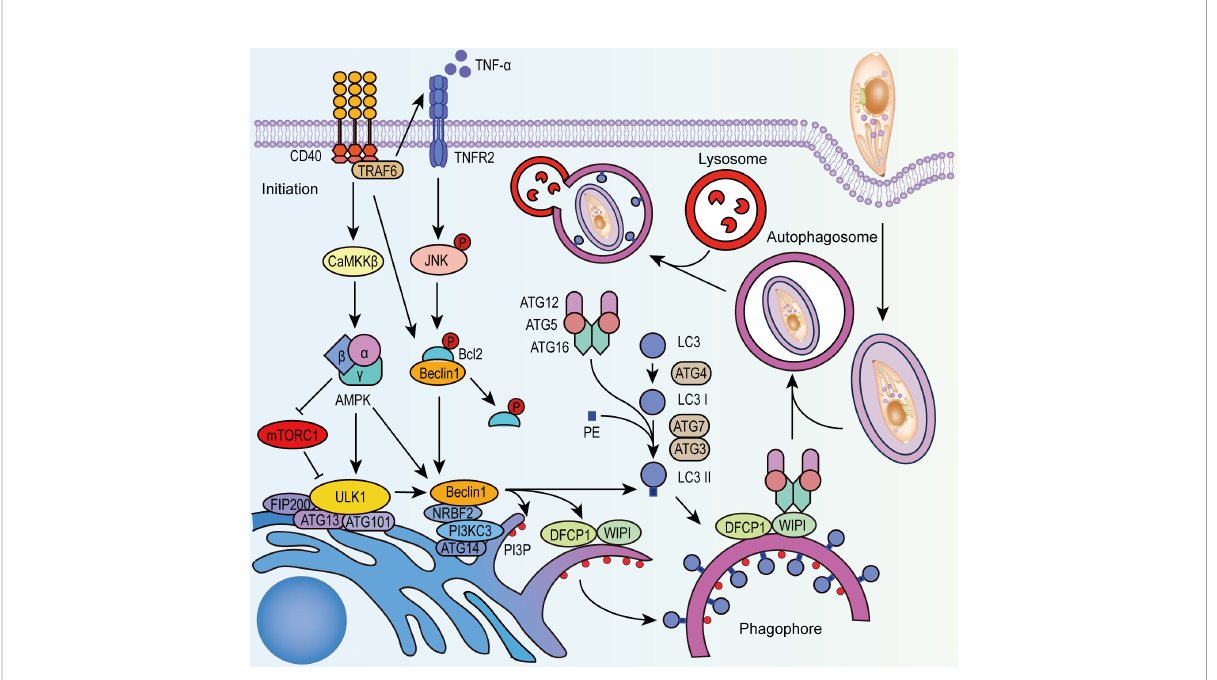
FIGURE 1 CD40 stimulates autophagy in T. gondii infection. After the invasion of T. gondii, CD40 activates ULK1 through CaMKK b -AMPK signaling and releases Beclin1 from phosphorylated Bcl-2. AMPK also alleviates the negative regulation of mTORC1 to ULK1. CD40 promotes the activation of TNFR-JNK signaling through phosphorylation. Activated ULK1 complex and Beclin 1-PI3KC3 complex recruit PI3P, DFCP1, and WIPI to form phagophore. With the recruitment of LC3-II that is lipidated from LC3 by ATG4, ATG7, ATG3, and ATG12-ATG5-ATG16 complex, the phagophore expands and closes to form autophagosome that encapsulates PV of T. gondii, and fuses with lysosomes to degrade the parasites. PI3P, phosphatidylinositol-3-phosphate; NRBF2, nuclear receptor binding factor 2; AMBRA1, BECN1-regulated autophagy protein 1; DFCP1, double FYVE domain-containing protein 1; WIPI, WD-repeat protein interacting with